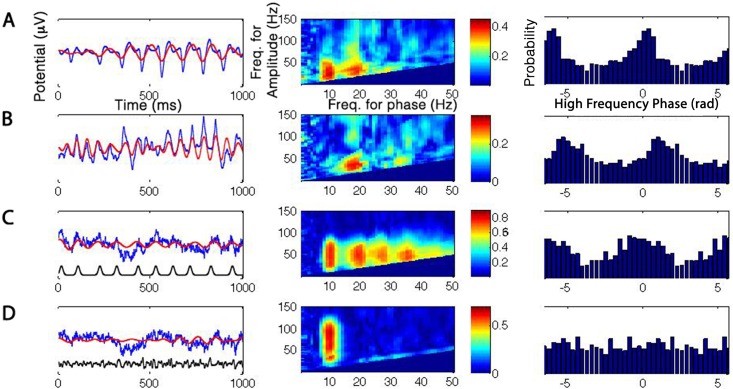
Waveform-dependent CFC in empiric signals.Left column: example traces of each analyzed signal. The blue trace is the raw trace, and the red is the low-frequency band-pass filtered component. Black trace in the bottom two rows shows the artificial data added to induce CFC. Middle column: comodulogram showing the PLV value for each frequency-pair. Right column: Phase-phase dependency: histogram of high-frequency phase values (in radians) occurring at the preferred phase of the low-frequency cycle (i.e. the phase for which high-frequency amplitude is maximal) for the basic rhythm frequency (10Hz for A,C,D, 17Hz for B) with its first harmonic (20Hz for A,C,D, 34Hz for B). The histogram is repeated twice along its horizontal axis to improve readability. A, Intracranial recording of mu oscillations (~10Hz). B, Intracranial recording of beta oscillations (~17Hz). Note the non-sinusoidal single sharp peaks driving the oscillatory component in A and B, as well as the harmonics in the comodulogram and the non-uniform phase-phase relation between the low- and high-frequency components. C, CFC induced by superimposing a periodic Gaussian train on a background EEG trace, featuring no CFC initially. D, "Coupled-sources" CFC induced by modulating the amplitude of the 30-100Hz band by the instantaneous 10Hz phase. Note the similar behavior of A, B compared to C and not to D.